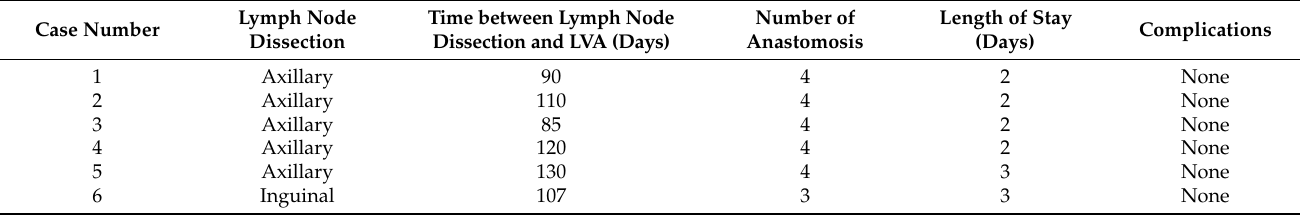
Table 2. Operative details, postoperative